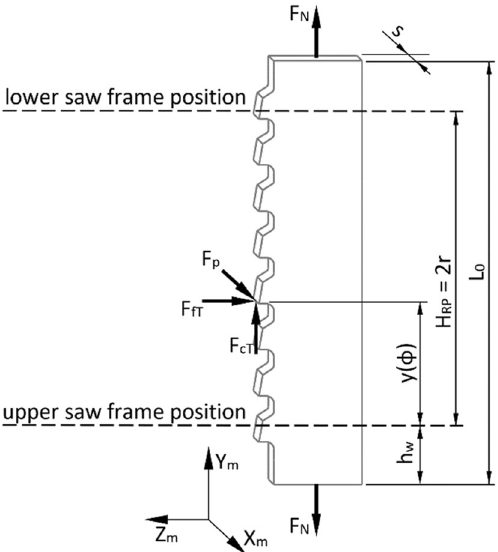
Figure 2. Loads on the saw during operation; where: F N is the tensioning force (the force stretching the saw blade in the longitudinal direction—Y m axis of the sawing machine’s coordinate system); F cT is the total cutting force; F fT is the total feed force; F pT is the total thrust force to load the saw; L 0 is the free saw blade length; h w is the feed roller level; H RP is the saw frame stroke; r is the crank radius in the driving system; s is the saw blade thickness; y(φ) is the position of the point of application of force as a function of the angle of rotation φ of the crank in the main drive of the sawing